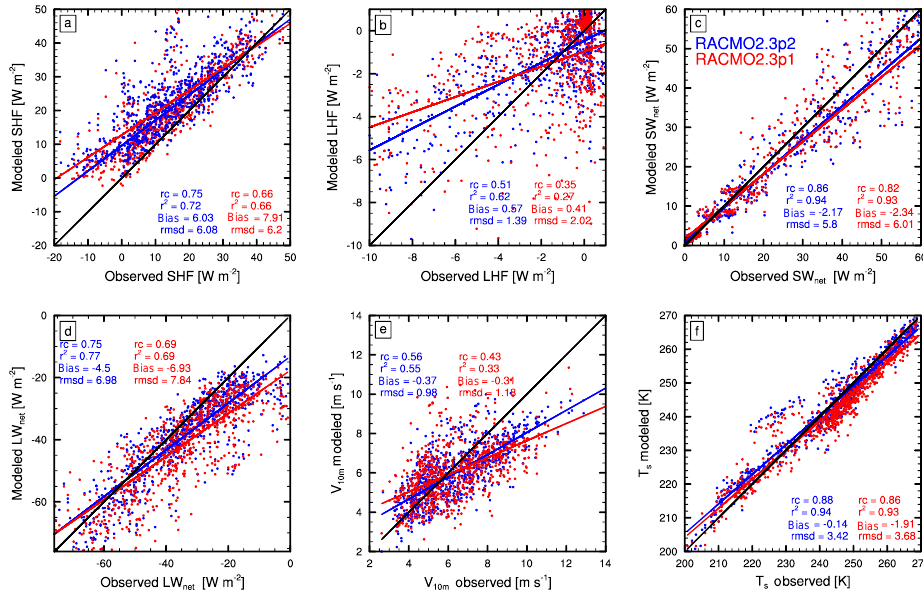
Figure 4. Correlation plots of RACMO2.3p2 (blue) and RACMO2.3p1 (red) as a function of the observation for monthly averages of the (a) sensible heat flux (SHF), (b) latent heat flux (LHF), (c) SW net , (d) LW net , (e) V 10m and (f) T s . Denoted for all variables are the slope Rc, determination coefficient r 2 , bias and root mean square deviation (RMSD) for both model versions.